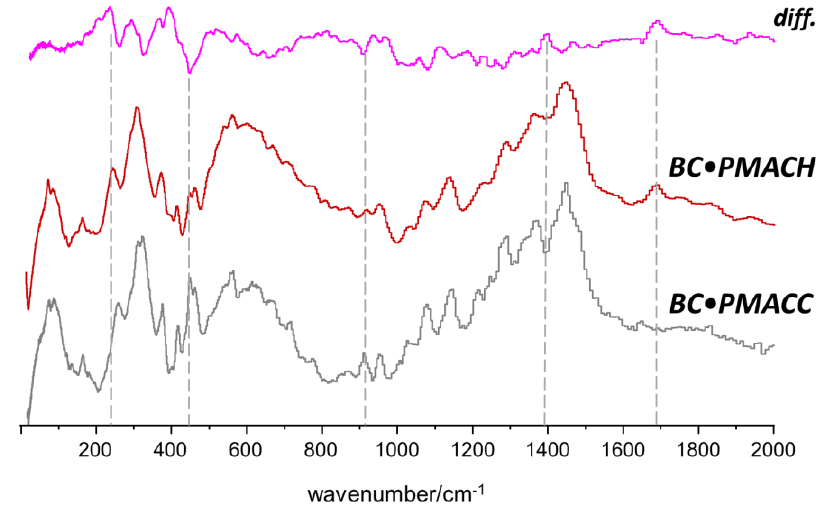
Figure 7. INS spectra of BC•PMACH and BC•PMACC nanocomposites in the 20–2000 cm −1 range.